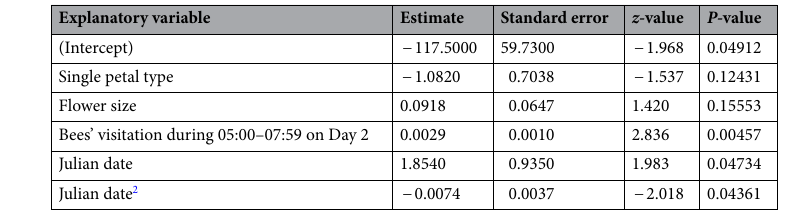
Table 3. Results of logistic regression analysis examining factors affecting seed set of lotus flowers. The number of photos taken of bees during 05:00–07:59 (the time period when the AIC value was lowest), petal type (single or double), number of ovules (an index of flower size) and Julian date (number of days from 1 April 2018 to day 1) were used as explanatory variables. The number of mature seeds per flower was assumed to follow a binomial distribution with the number of ovules as the upper